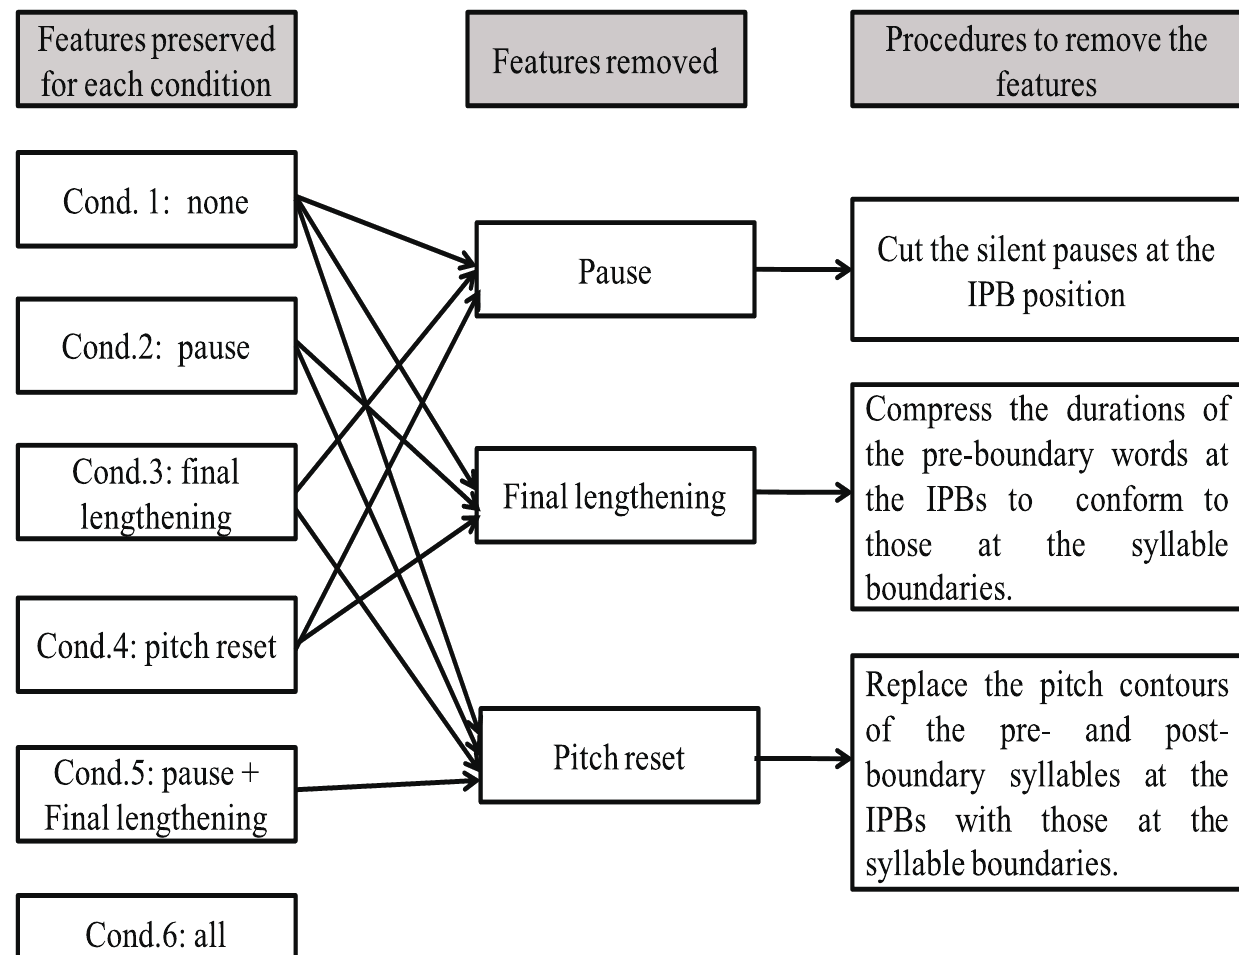
Figure 1. The procedures used to create the experimental conditions.